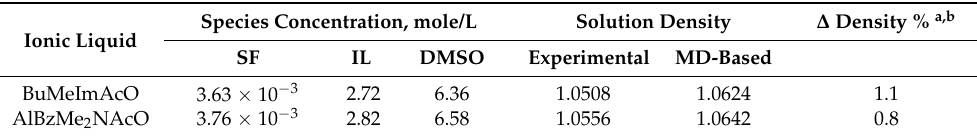
Table 1. Concentrations of the species in the molecular dynamics’ simulation boxes, calculated and experimental densities. Species Concentration, mole/L Solution Density ∆ Density % a,b Ionic Liquid SF IL DMSO Experimental MD-Based